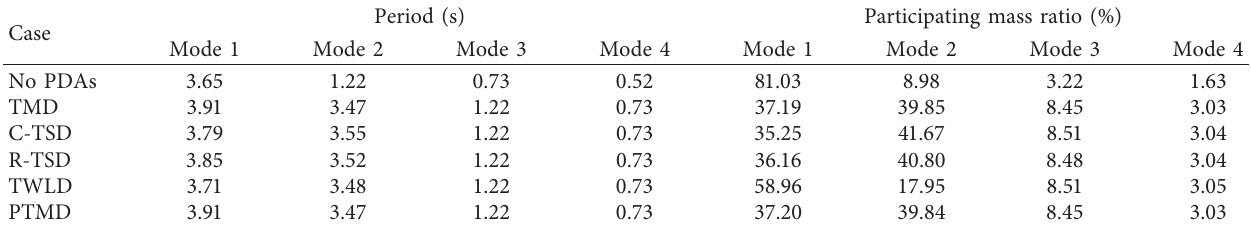
Table 15: Periods and participating mass ratios for xz plane of the building with a single PDA: seismic